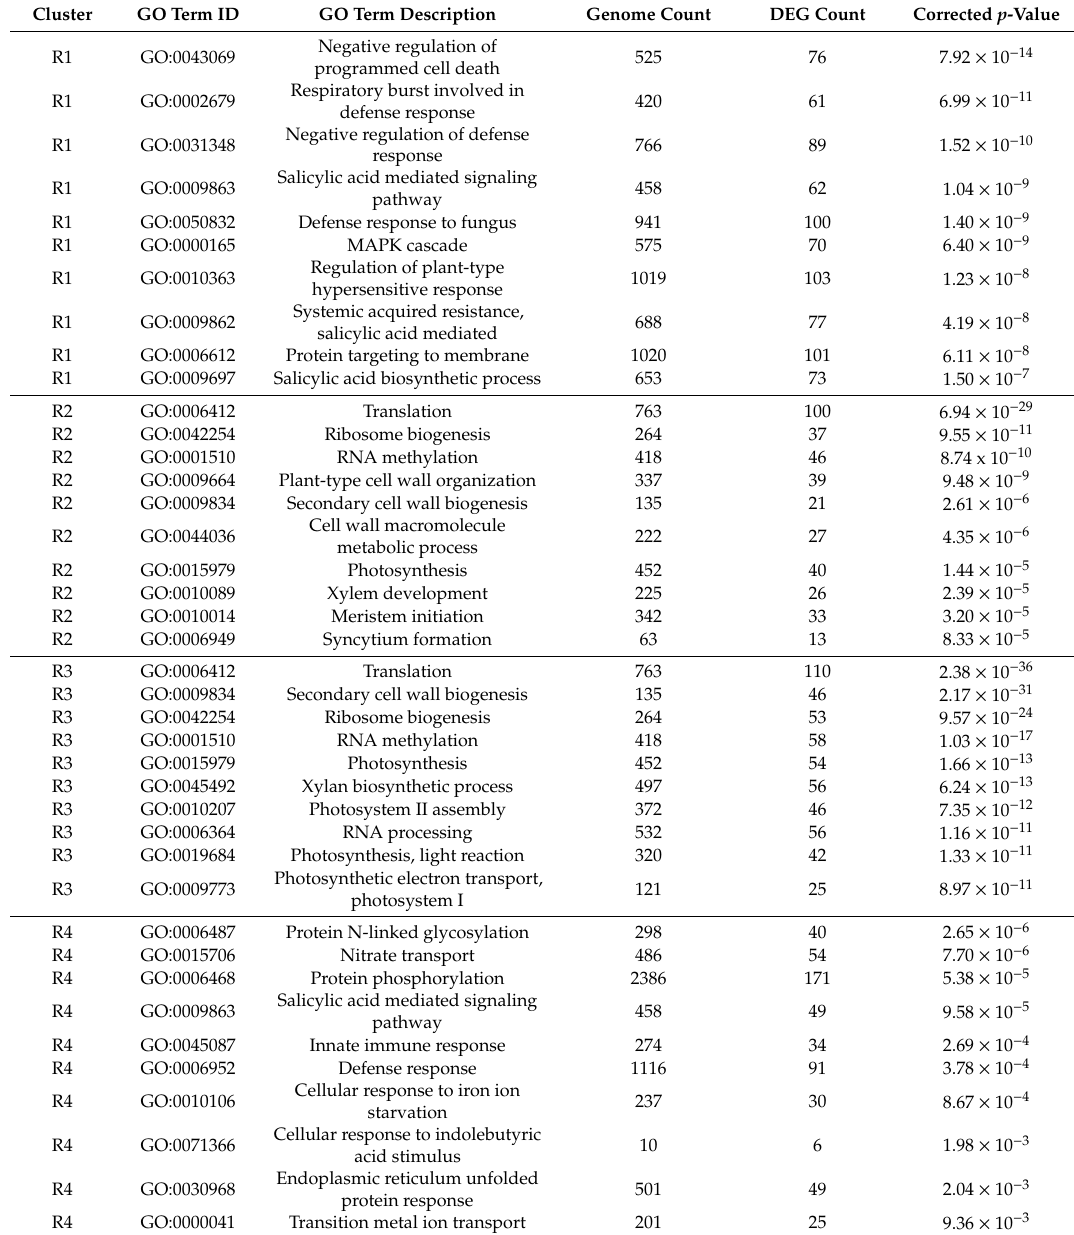
Table 2. Top ten GO Biological Process terms significantly overrepresented in root expression clusters